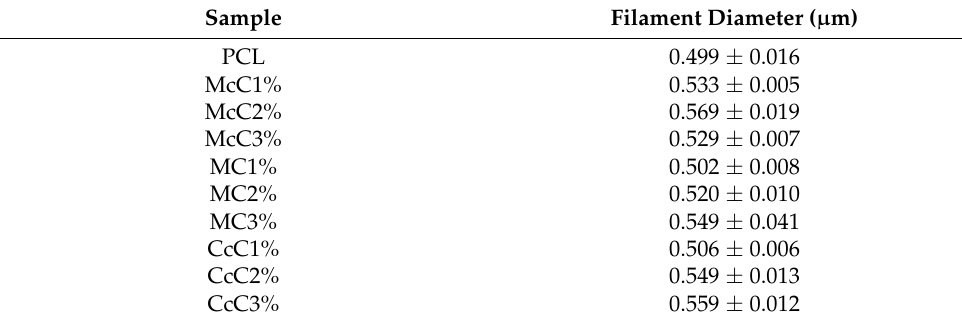
Table 3. Filament diameter (mean ± SD) manufactured for mechanical tensile